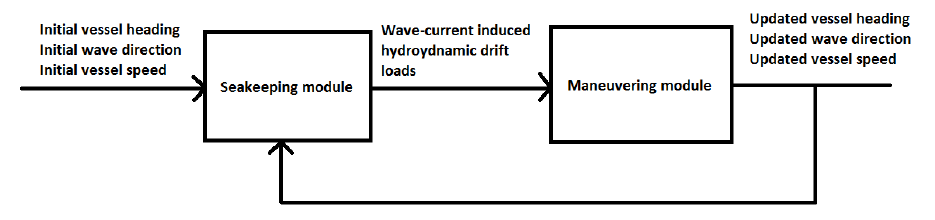
Figure 4. Process diagram of numerical maneuvering